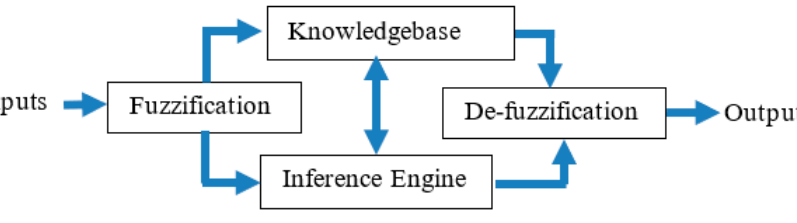
Figure 1. Schematic diagram of a fuzzy inference system (FIS).